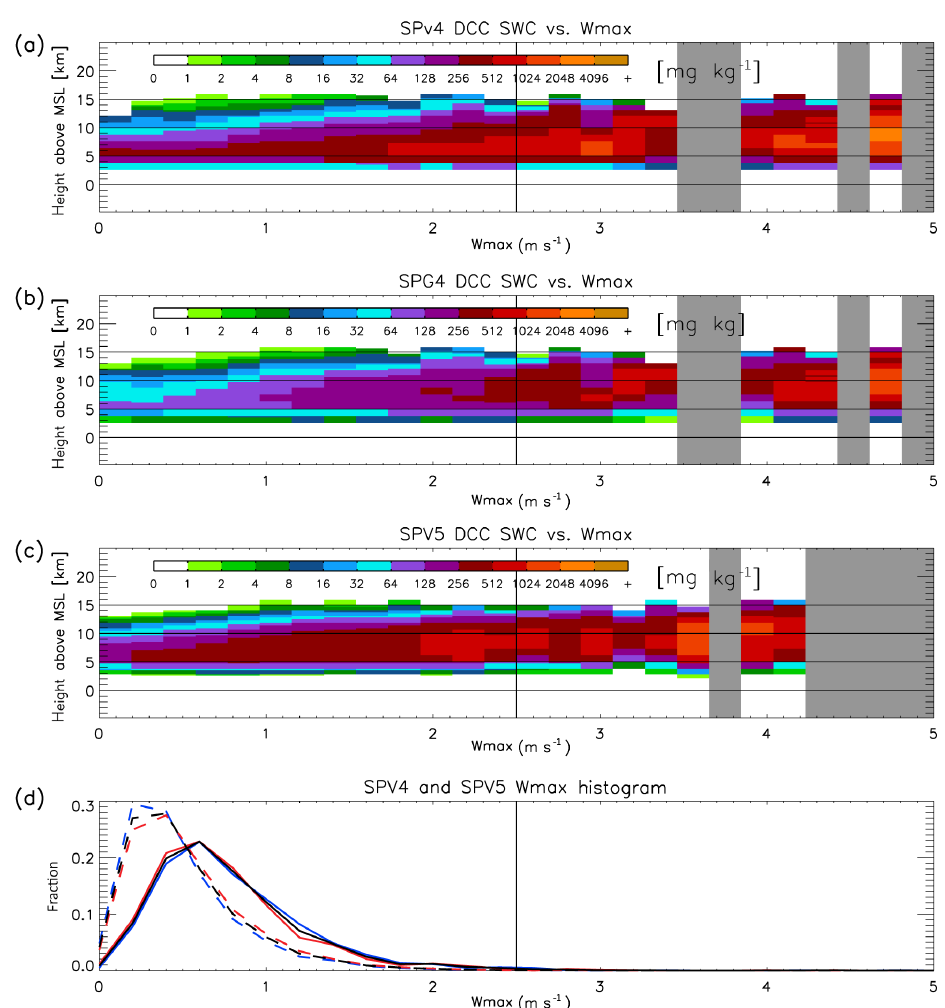
Figure 9. Same as Fig. 8, but for snow water content (SWC). Because SPV4 does not distinguish between snow and graupel, all precipitating ice is depicted as